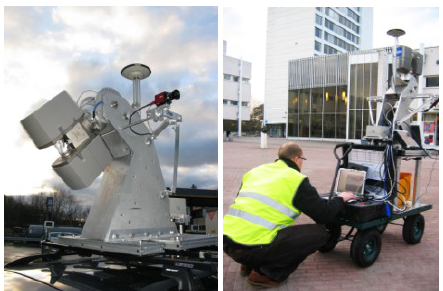
Figure 1. Left: ROAMER as a vehicle MLS (Photo courtesy Hannu Hyyppä). Right: Trolley MLS installation.